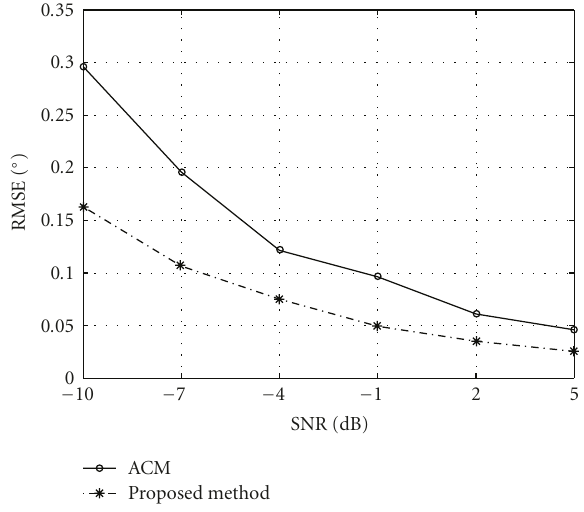
Figure 3: RMSE of the proposed method and ACM when one signal impinges onto the